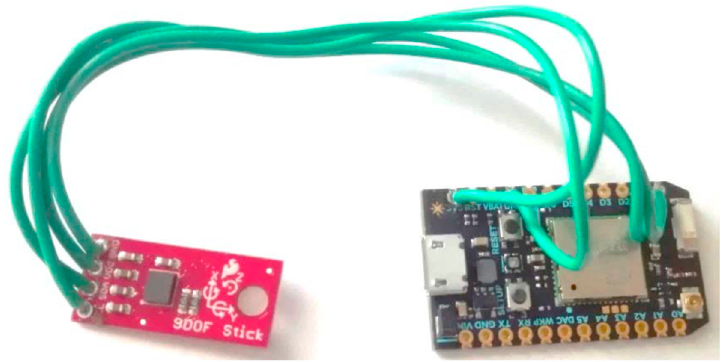
Figure 2. The Particle Photon with the accelerometer.